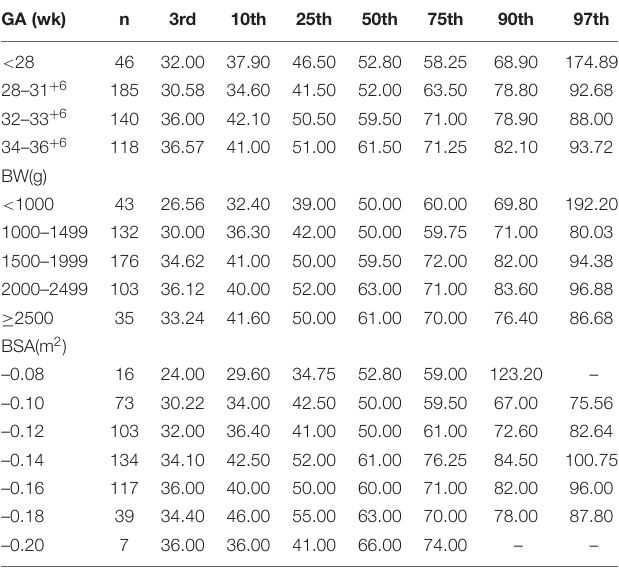
TABLE 9 | Doppler maximum velocities of AV (cm/s) (from 3rd to 97th centiles) in relation to GA, BW, and BSA in preterm infants.